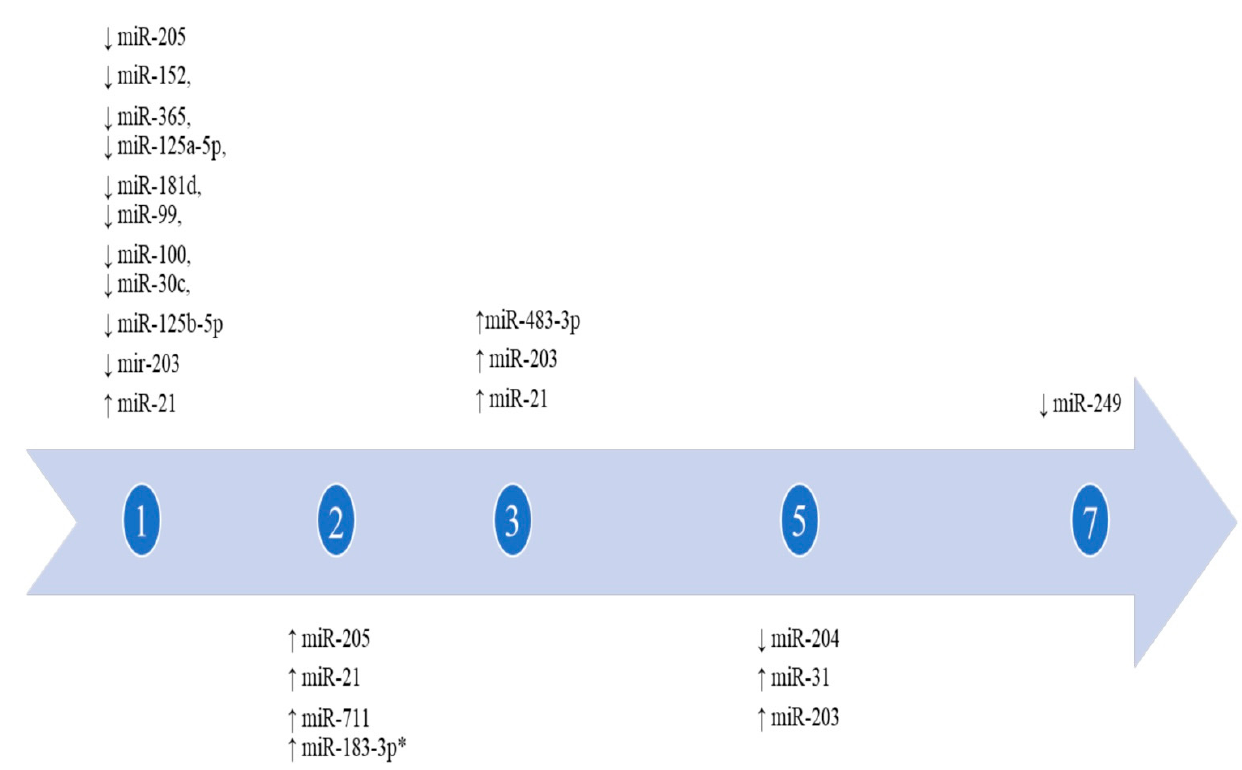
Figure 2. This figure represents the progressive expression of different miRNAs in time (days) after wounding. Only those miRNAs that are expressed according to a precise timeframe were considered. Only the first day of increase is shown. * miR-183-3p shows a different behavior between humans and rats; it was detected overexpressed in humans over 2 days and in rats over the course of 120 days. ↑ indicates up regulation, ↓ indicates down regulation.